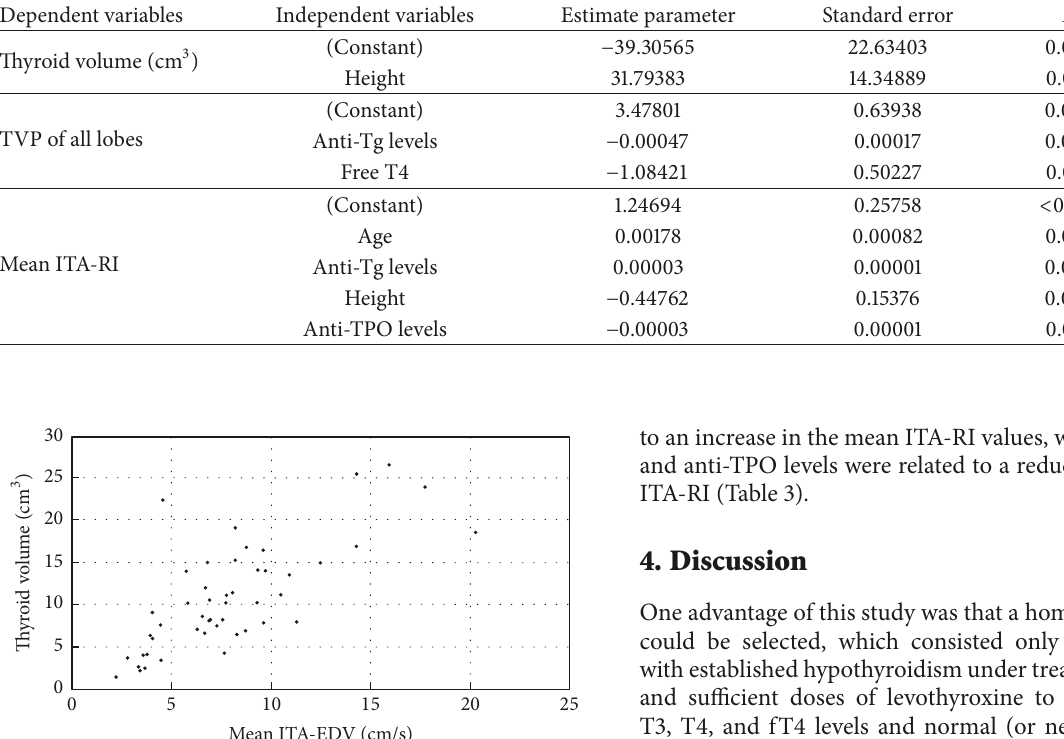
Figure 4: Scatterplot showing the relationship between the mean ITA-EDV (cm/s) and thyroid volume (cm 3 ): 𝑟 = 0.711 ; 𝑃 < 0.001 .